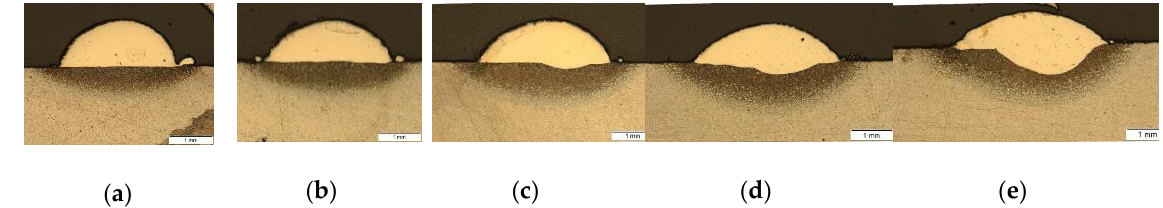
Figure 5. Cross-sections of a single Ni-20Cr+Re bead produced by laser cladding on 16Mo3 steel substrate at different laser power values: ( a ) 1500 W, ( b ) 1800 W, ( c ) 2100 W, ( d ) 2400 W, ( e ) 2700 W.